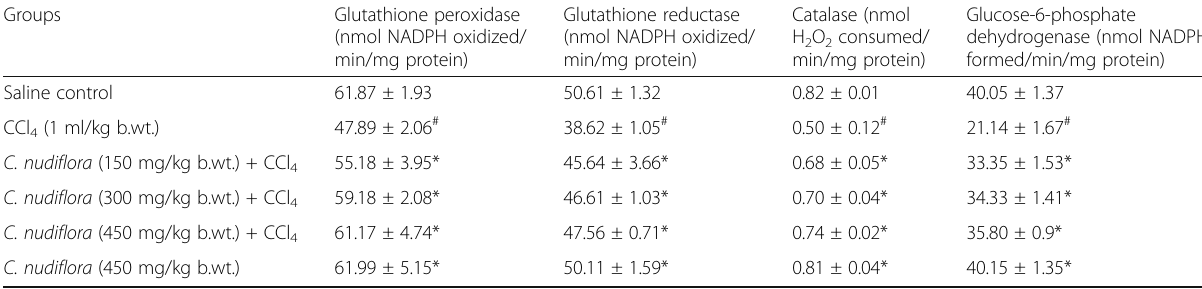
Table 3 Effect of C. nudiflora on CCl 4 -induced changes in antioxidant enzymes